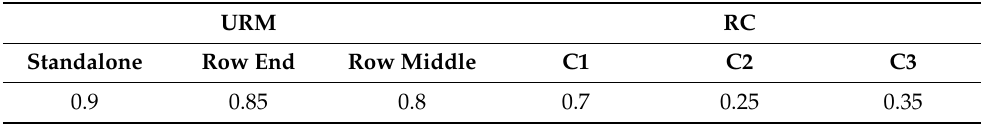
Table 2. Structural system transformation for URM and RC buildings (compiled by authors based on Tesfamariam & El Sabbagh